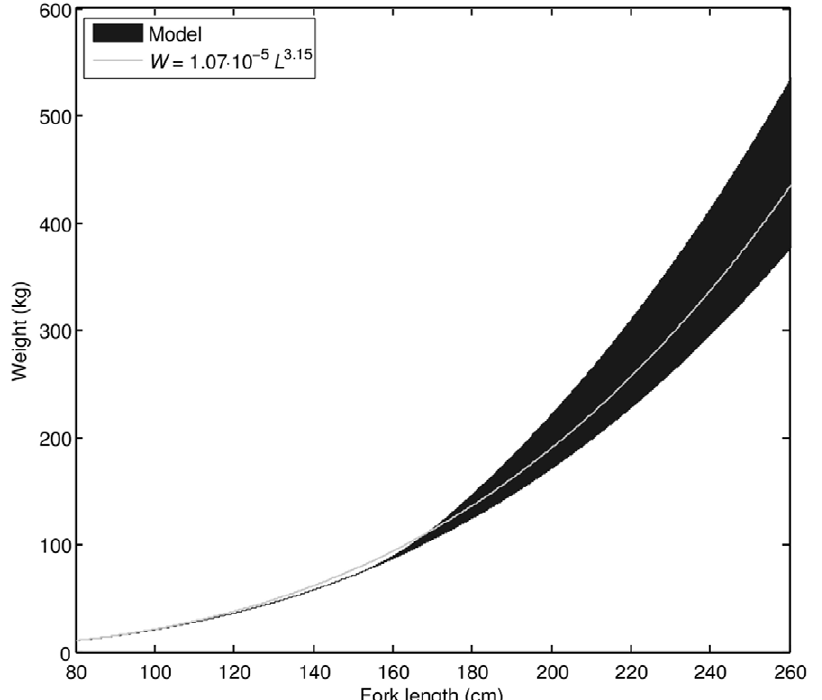
Figure 7. The weight-length relationship in the juvenile and adult stages; comparison of model results to the weight-length relationship available in literature [ 46 ] . Shaded area indicates that, even at constant food level, weight of an adult individual at a given length will vary greatly depending on the reproductive activity of the fish.